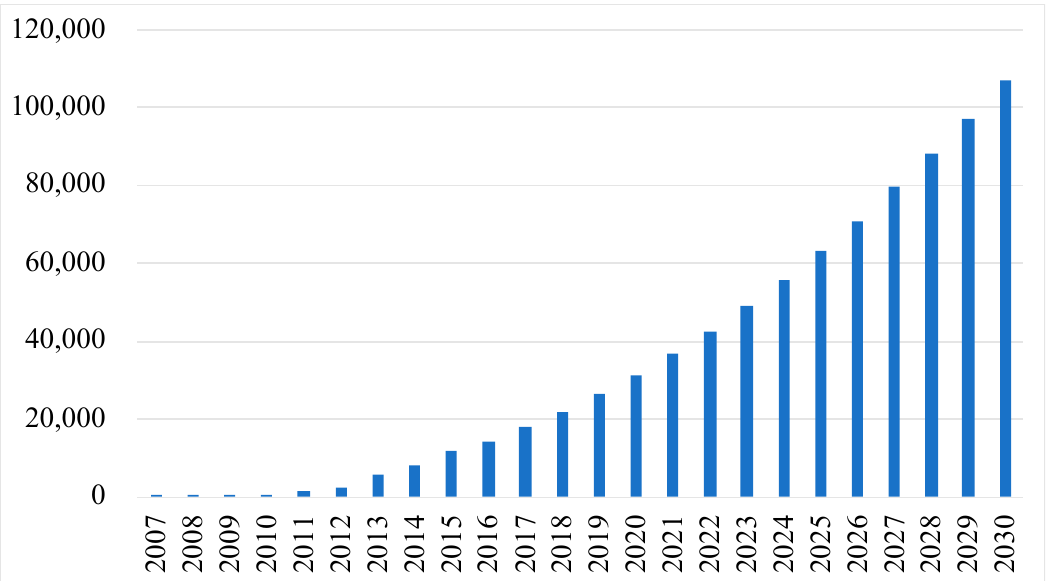
Figure 10. Scenario analysis on the End-of-Life HV number in Mongolia. Source: Figure made by the author based on the hypothesis in 4.1. and data from Automobile Inspection & Registration Information Association ′ s data [20].